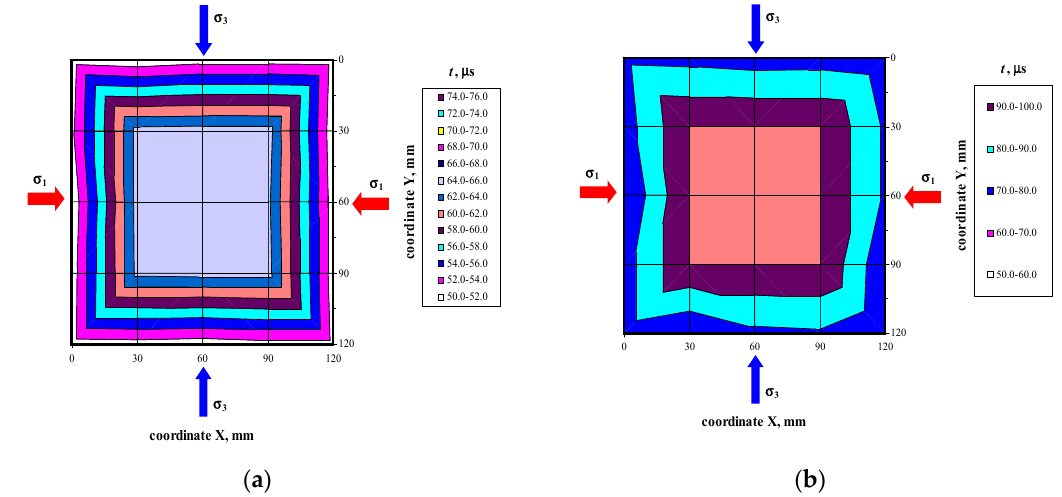
Figure 5. View of the test stand in operation: ( a ) overall view, ( b ) specimen view; 1—the test stand with the fixed actuators; 2—a test element; 3—the hydraulic system ‘A’; 4—the hydraulic system ‘B’; 5—the measurement and control interface; 6—IT system; 7—cameras of the ARAMIS 6M system; 8—PUNDIT LAB+ instrument.